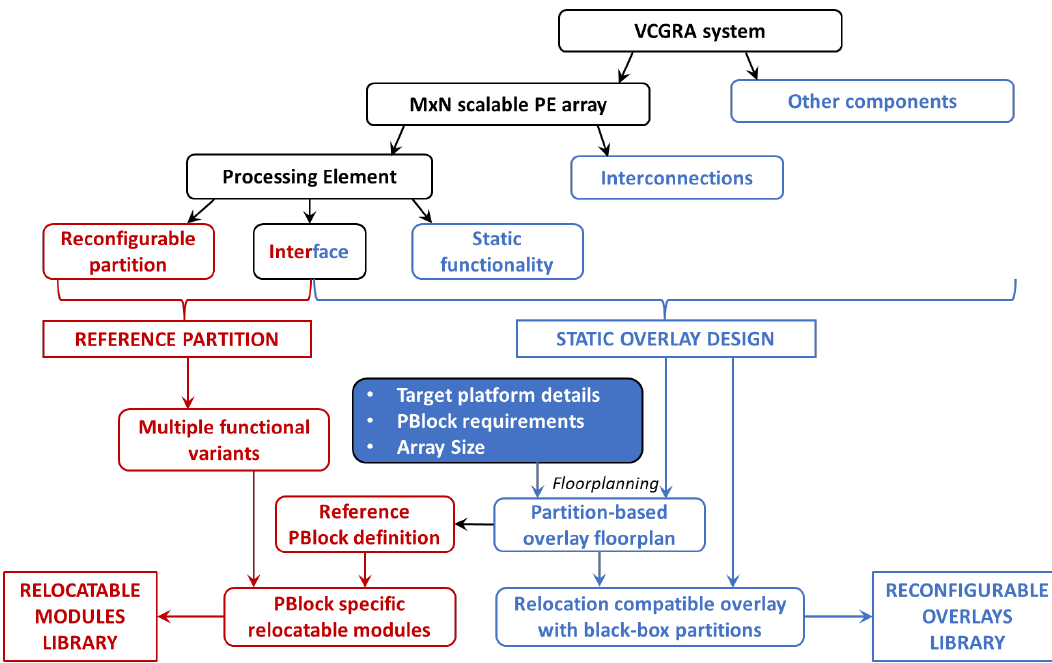
Figure 6. VCGRA with relocatable partitions—back-end mapping design flow